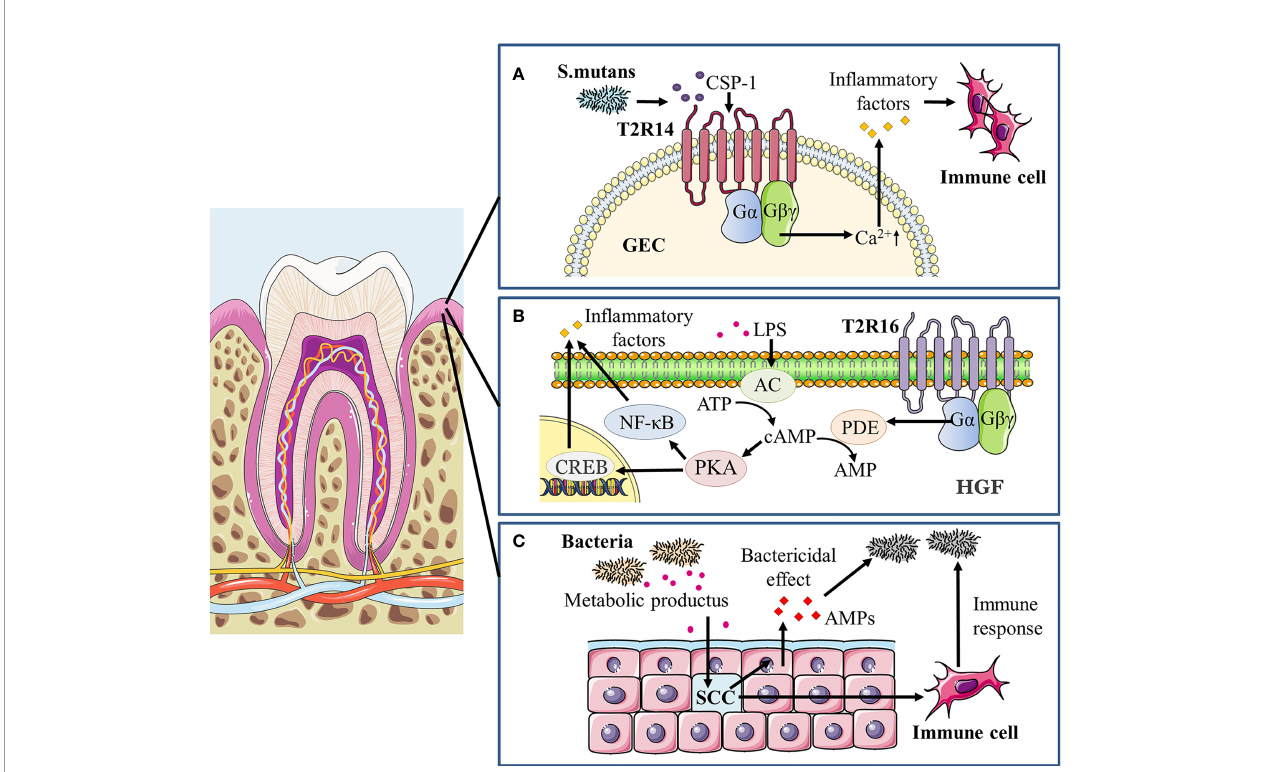
FIGURE 2 | Taste receptors modulate oral immune response to microorganisms. (A) In gingiva epithelial cells (GECs) treated with S. mutans competence stimulating peptide-1 (CSP-1), a vigorous increase in intracellular calcium mobilization and secretion of cytokines/chemokines including IL-6, IL-8 and TNF- a occurred primarily through the T2R14-G bg -PLC b pathway, recruiting immune cells and mediating the immune response to pathogens. (B) LPS can induce a signi fi cant dose- and time-dependent increase in adenylate cyclase (AC) activity and thereafter elevates intracellular cAMP levels, positively affecting NF- k B activity through its major effector protein kinase A (PKA) and stimulating in fl ammatory responses. In addition, the cAMP/PKA/cAMP response element binding protein (CREB) signaling pathway may promote the LPS-induced release of pro-in fl ammatory cytokines, including IL-6, IL-33, and TNF- a . In human gingival fi broblasts (HGFs), agonist-stimulated T2R16 mobilizes downstream a -gustducin to activate the phosphodiesterase (PDE) that hydrolyzes cAMP, thereby reducing intracellular cAMP levels and alleviating the LPS-induced in fl ammation as well as tissue injury. (C) Taste receptors of gingival solitary chemosensory cells (gSCCs) activated by bacterial metabolites would stimulate epithelial cells to release antimicrobial peptides (AMPs) as a direct bactericidal effect and also recruit immune cells to modulate the oral immune